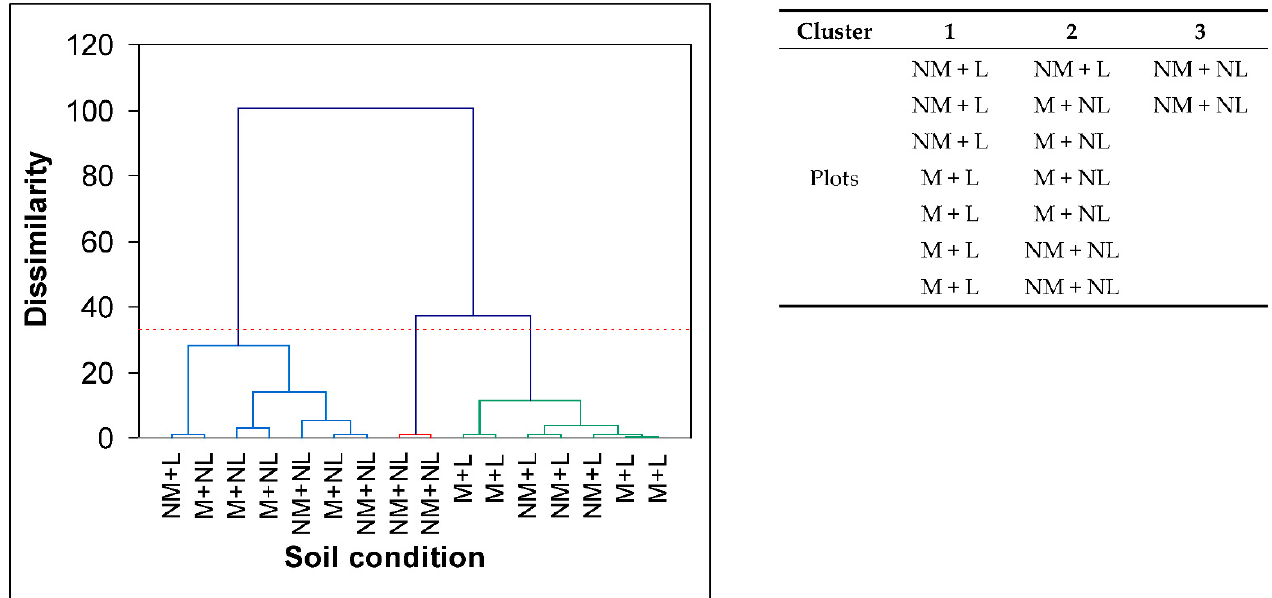
Figure 4. Dendrogram of the original variables (main chemical properties of soils) and cluster com ‐ positions provided by the Agglomerative Hierarchical Cluster Analysis (AHCA) applied to obser ‐ vations of the growth of Pinus halepensis Mill. in plots subjected to four treatments in the Sierra de Los Donceles forest (Liétor, Castilla La Mancha, Spain); the y ‐ axis of the dendrogram reports the similarity level, while the red dotted line reports the clustering level . Legend: M + L = mulching + logging; NM + L = no mulching + logging; NM + NL = no mulching + no logging; M + NL = mulching + no logging.